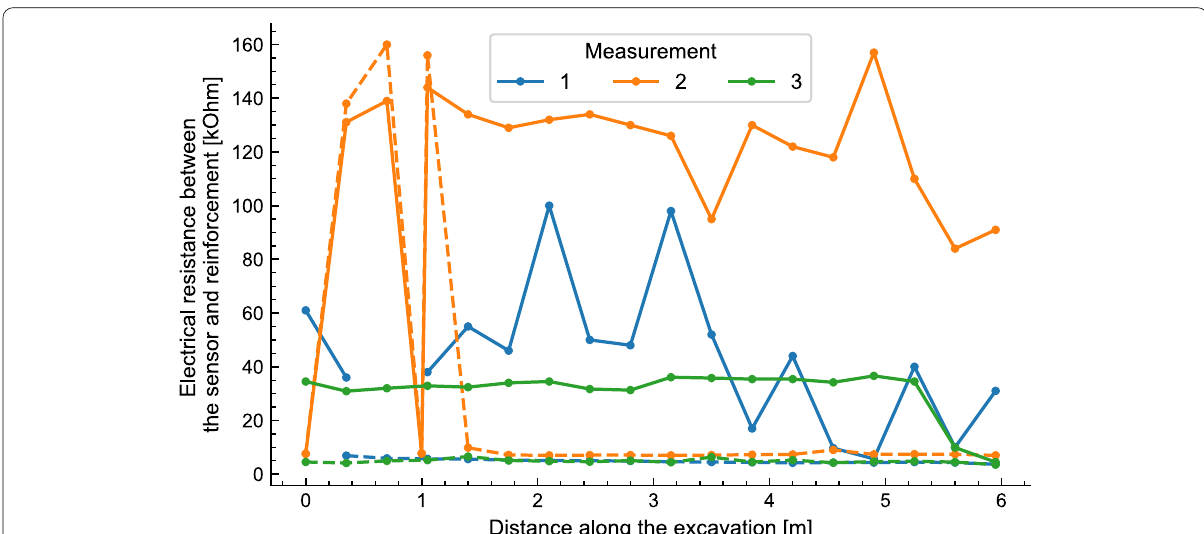
Fig. 16 Result of the electrical resistance measurement at different distances from the steel for the field measurement (all measurements corrected by the internal resistance of the electrode). The colors indicate the number of the measurement (see Table 1). The solid line represents the resistance while the sensor is positioned inside the protective tube, whereas the dashed line represents the resistance when the sensor is pressed against the ground by turning the lever controlling the push-out